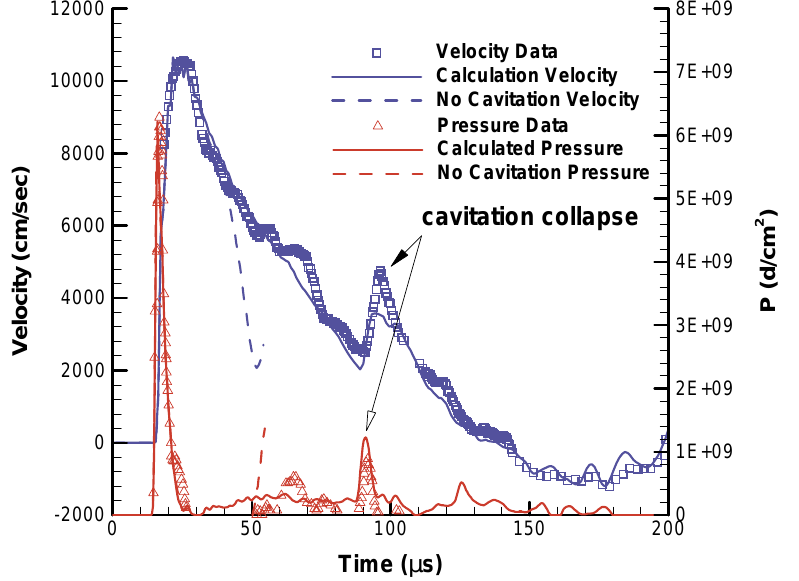
Fig. 7. Single wall cylinder pressure and velocity history. Fig. 7 for the single walled cylinder. A consequence of this omission is that water experiences tension, rather than cavitation. Although this simulation terminates at 65 µ s, the solution at this time demonstrates cylinder reloading. Here a low pressure region between the bubble and cylinder wall is annihilated by the inflow of surrounding high pressure fluid. The impact of the omission of the cavitation model is to limit the water expansion, which curtails cylinder deformation. This accounts for the decrease in the wall velocity for t > 50 µ s shown in Fig.